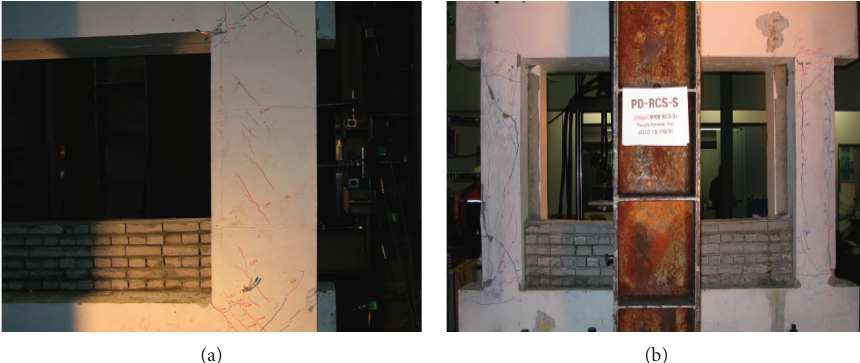
Figure 24: Cracks appeared in the PD-WESRCF specimen during pseudodynamic testing at 500gal after (a) 2.16s with lateral displacement of 33mm and force of –641kN, and (b) during the final stage